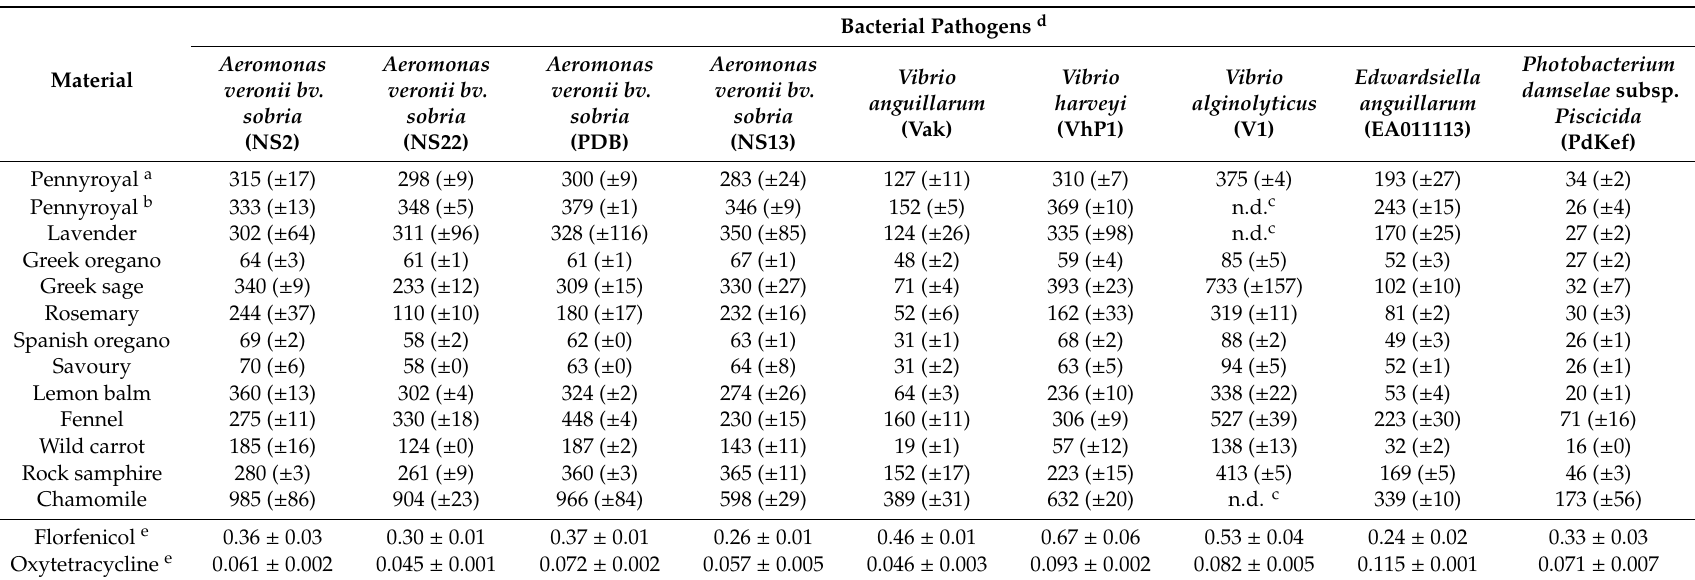
Table 2. The average IC 50 values (in µ g mL − 1 ) of the investigated essential oils and two standard antibiotics (positive controls) against nine bacterial fish pathogens (standard deviation is presented in